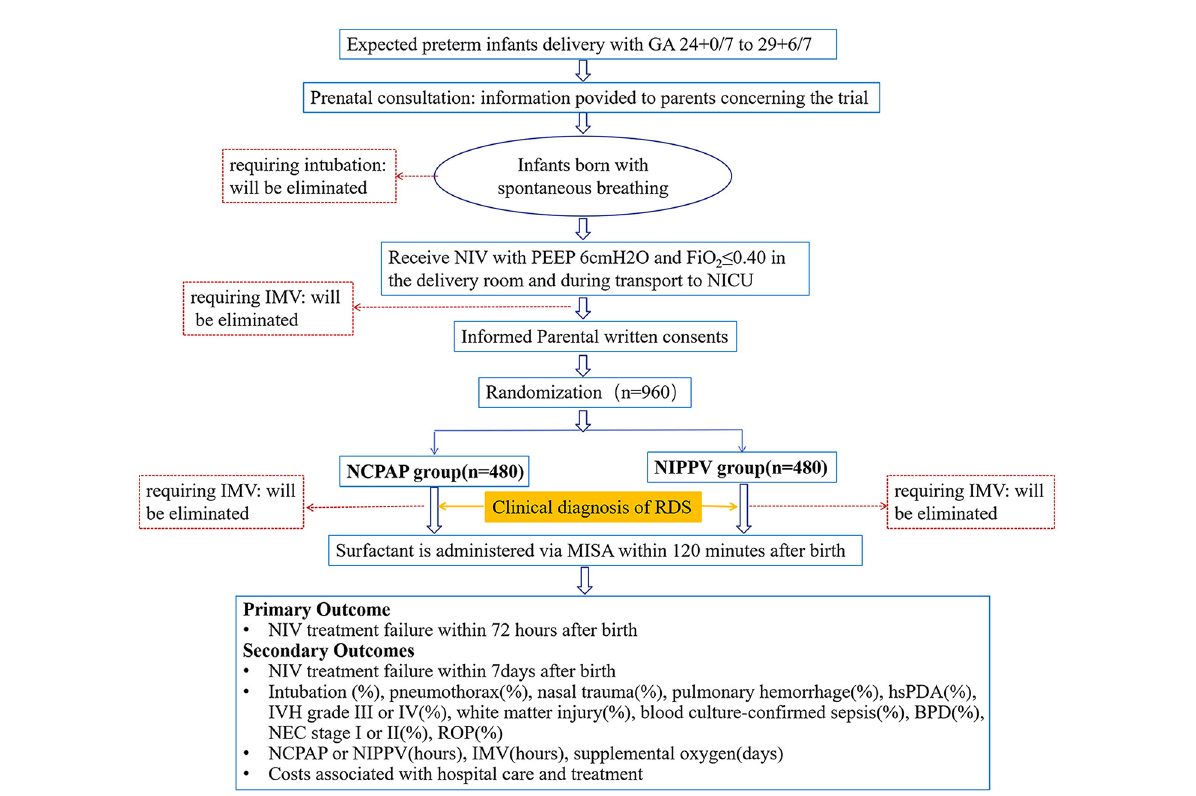
FIGURE1 Prospective flow chart of the study. NCPAP, nasal continuous positive airway pressure; NIPPV, non-invasive positive pressure ventilation; GA, gestational age; IMV, invasive mechanical ventilation; NIV, non-invasive ventilation; RDS, respiratory distress syndrome; MISA, minimally invasive surfactant administration; hsPDA, hemodynamically significant patent ductus arteriosus; IVH, intraventricular hemorrhages; BPD, bronchopulmonary dysplasia; NEC, necrotizing enterocolitis; ROP, retinopathy of